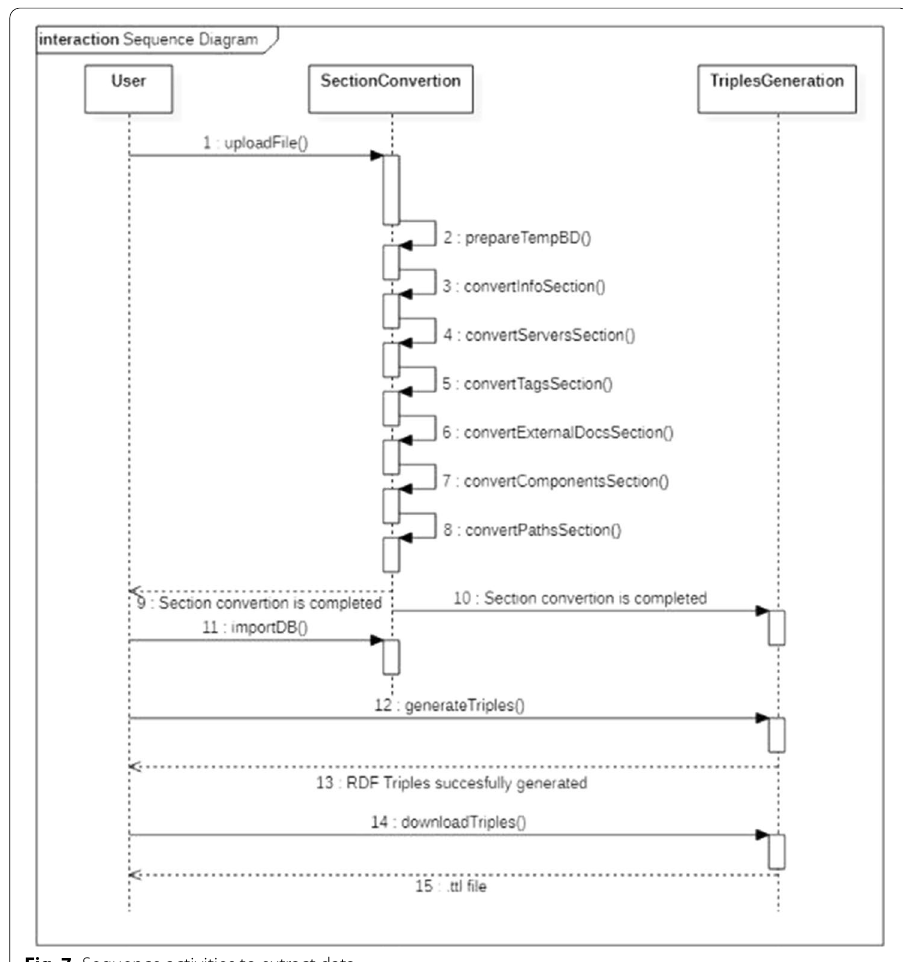
Fig. 7 Sequence activities to extract data